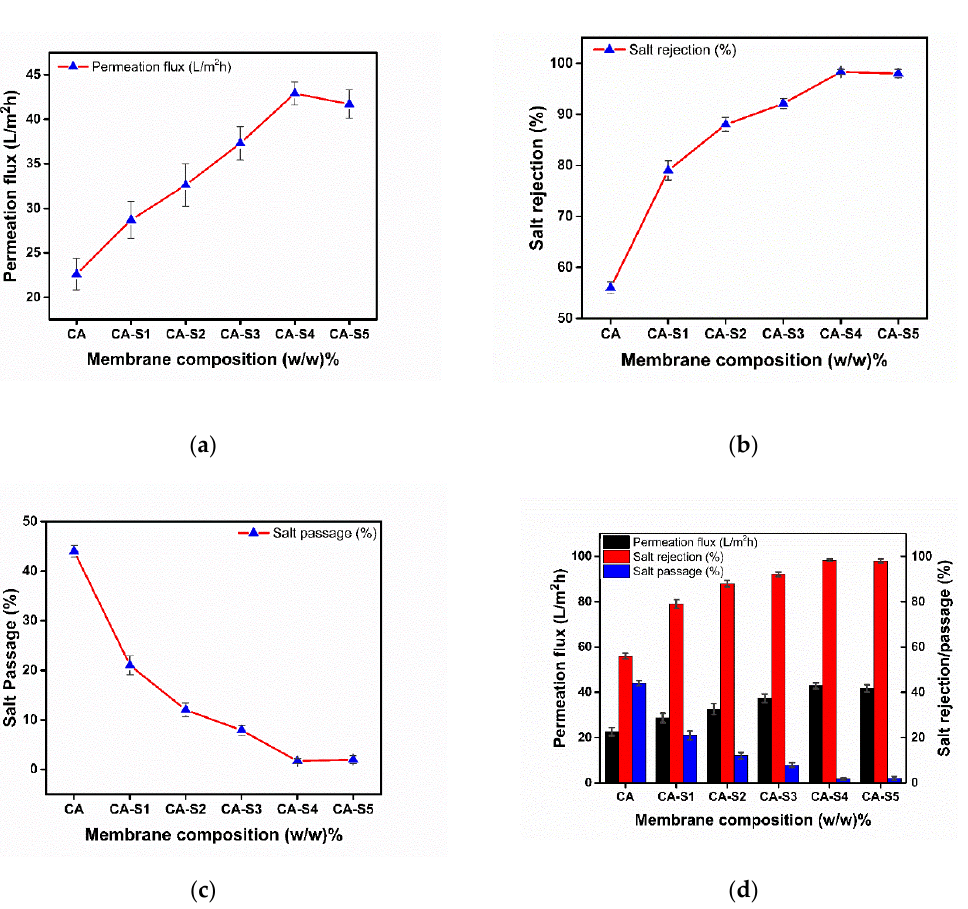
Figure 3. ( a ) Permeation flux (L/m 2 h) through an NF-TFC membrane. ( b ) Salt rejection (%) through an NF-TFC membrane. ( c ) Salt passage (%) through an NF-TFC membrane. ( d ) Combined graph of permeation flux (L/m 2 h), salt passage (%), and salt rejection (%) through an NF-TFC membrane.